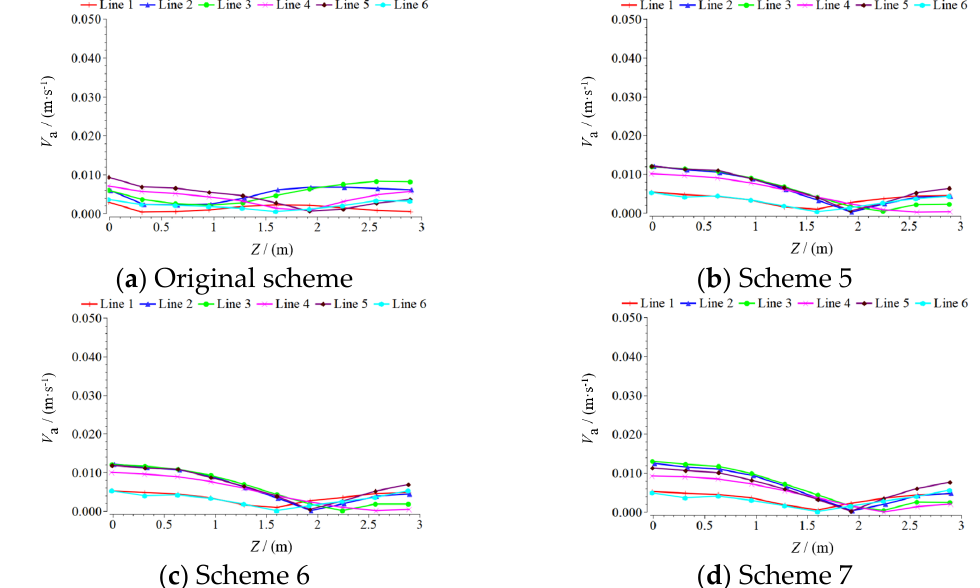
Figure 18. Diagram of axial velocity before the bell mouth in the sump 2#.